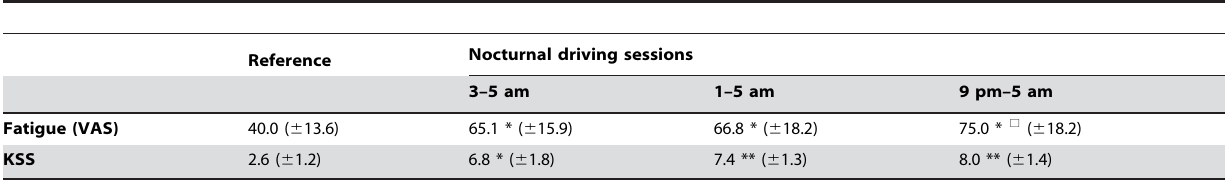
Table 1. Fatigue (VAS) scores after the last hour of driving (Mean 6 SD) and Karolinska Sleepiness Scale (KSS) scores before the last hour of driving (Mean 6 SD) in the reference session and in the 3 nocturnal driving